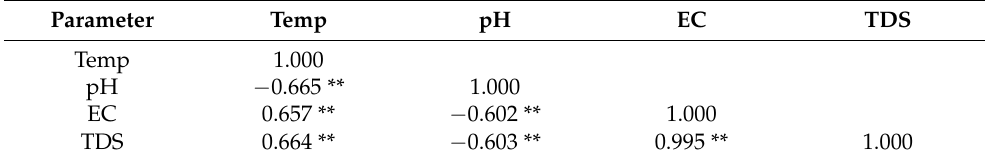
Table 3. Correlation matrix of the physicochemical